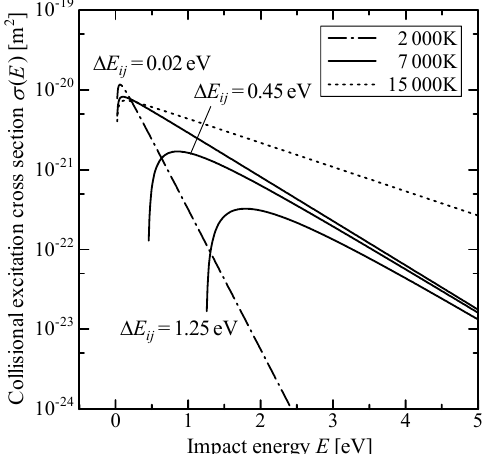
Fig. 1 Collisional excitation cross sections